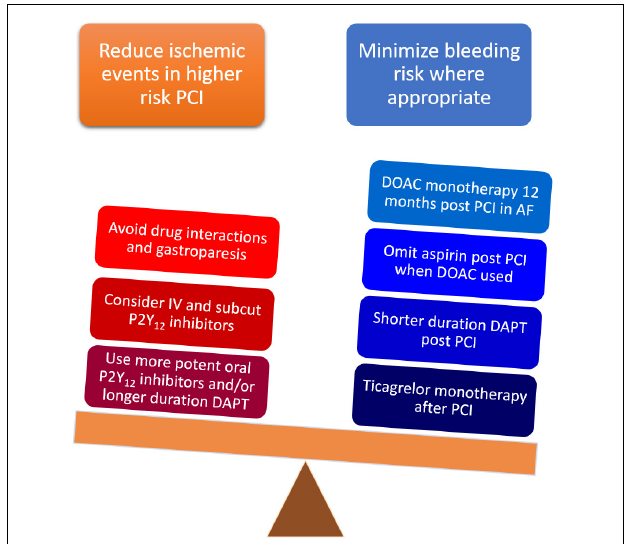
FIGURE 2 | Major challenges related to the contemporary use of P2Y 12 antagonists in clinical practice categorized by the two competing and inherently linked goals of reducing ischemic risk or minimizing bleeding